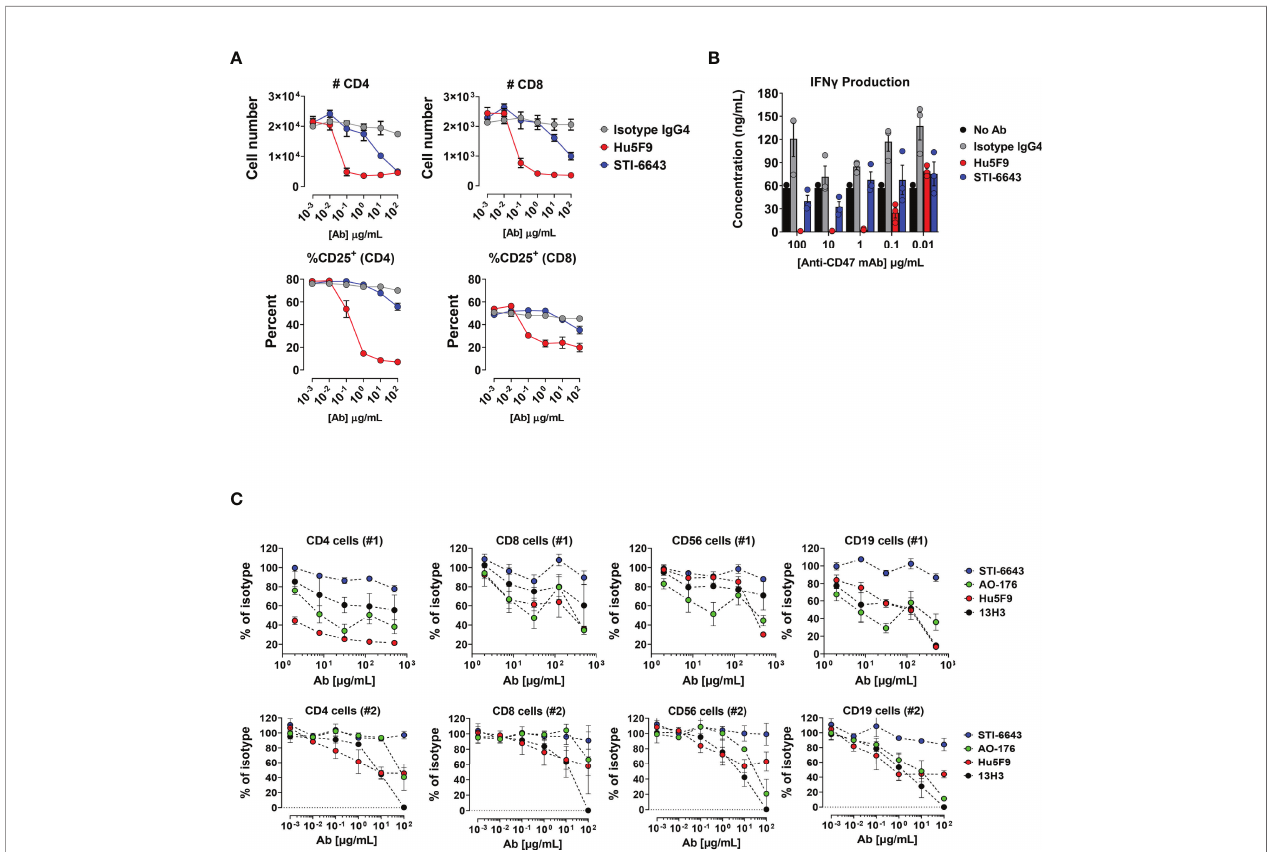
FIGURE 7 | Anti-CD47 clone STI-6643 preserved T cells survival and functionality in vitro . (A) Data from SEB assay performed in presence of anti-CD47 clones STI- 6643 (blue) and Hu5F9 (red) or isotype control. The number of CD4 + and CD8 + T cells as total cell counts (top panels) and frequencies of CD25 + activated T cells (bottom panels) recovered at the end of the assay is presented. (B) Quanti fi cation of IFN- g from culture supernatants of SEB assay at day 3. Data are representative of one experiment. (C) Frequency (percent of isotype control) of live immune cells recovered from 3-way MLR assays in presence of anti-CD47 (clones STI-6643, Hu5F9, AO-176 and 13H3) or isotype IgG 4 mAbs incubated at concentrations ranging from 2 to 500 µg/mL (#1; top panel) or 0.001 to 100 µg/mL (#2; bottom panel) without additional stimulation. Data were pooled from at least two independent experiments for each condition and cell numbers normalized to isotype values. Mean ± SEM